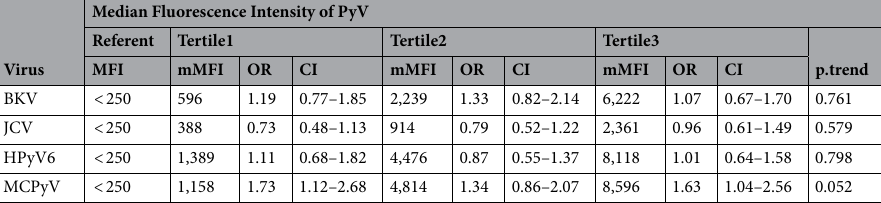
Table 3. Association of Polyomavirus seroprevalence and antibody titer with glioma risk in the Janus Serum Bank. Referent group in all analyses is comprised of seronegative individuals, i.e., MFI < 250. Median MFI in reference group is 110.5 for BKV; 81.0 for JCV; 9.0 for HPyV6; and 39.0 for MCPyV. Tertile cutpoints in the JANUS Serum Bank established among seropositive individuals. ORs and CIs were conditioned on